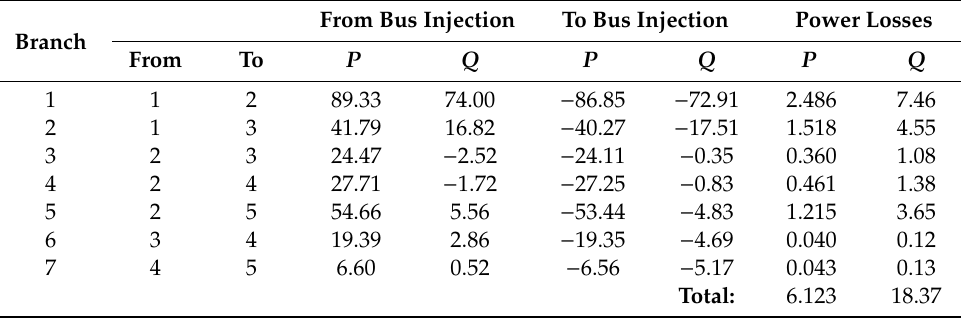
Table A2. Results of AC PF calculations in Case 1. AC branch data.